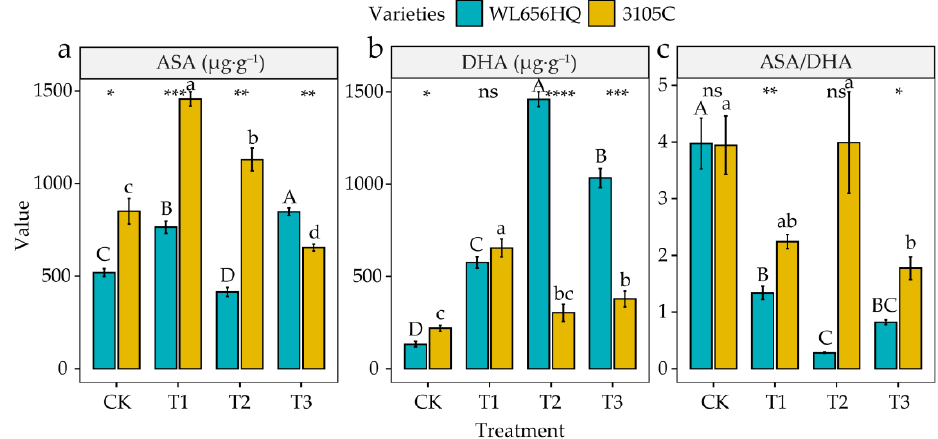
Figure 8. The effects of autotoxic extract on ASA, DHA Content, and AsA/DHA of alfalfa. The blue in the box plot represents the variety WL656HQ; the yellow represents the variety 3105C. The different lowercase and uppercase letters represent the significance of 3105C and WL656HQ at different concentrations. * Indicates the difference between the two varieties. The value p ≤ 0.05 is marked as *. The value p ≤ 0.01 is marked as **. The value p ≤ 0.001 is marked as ***. The value p ≤ 0.0001 is marked as ****. The value p > 0.05 is marked as ns. ( a ) ASA; ( b ) DHA; ( c ) AsA/DHA.